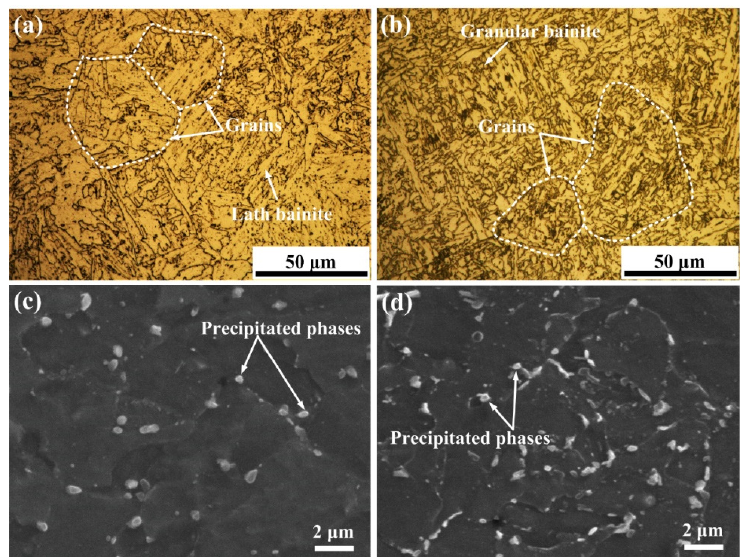
Figure 9. Microstructures of BL and WM obtained by OM and SEM. ( a ) OM micrograph of BL. ( b ) OM micrograph of WM. ( c ) SEM micrograph of BL. ( d ) SEM micrograph of WM.